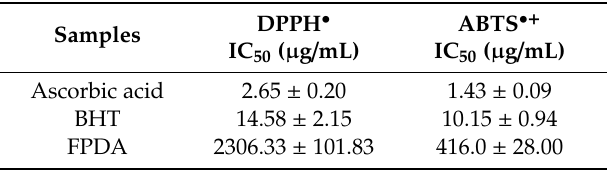
Table 2. Antioxidant activity of D. alata fruit pulp. ABTS: 2,2 (cid:48) -azino-bis-3-ethylbenzothiazoline-6- sulfonic acid, BHT: butylated hydroxytoluene, DPPH: 2,2-diphenyl-1-picrylhydrazyl, FPDA: fruit pulp of D. alata.